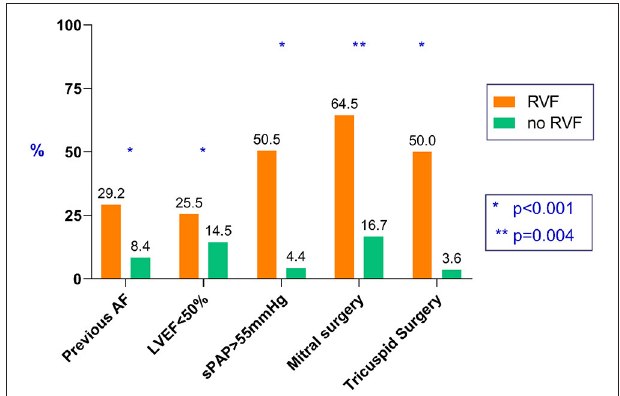
FIGURE 1 | Variables associated with post-operative right ventricular failure (RVF).